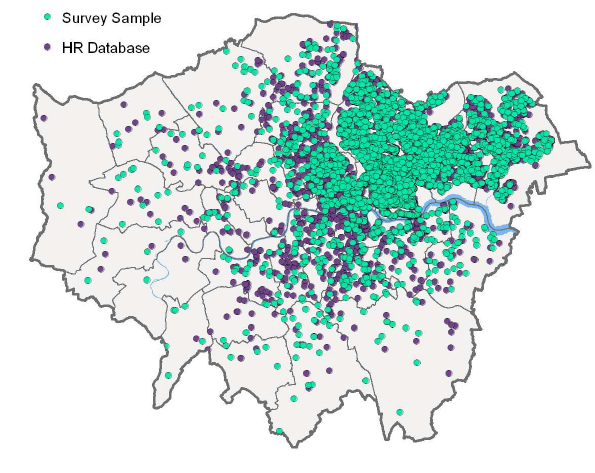
Figure 4. Comparison of Sources for Greater London Three measures of similarity of the distribution were made; relative clustering as per nearest neighbour ratio, the percentage of employees found inside and outside Newham, and the percentage found inside and outside the M25. As Table 5 shows, PC users were less likely to live in Newham, and